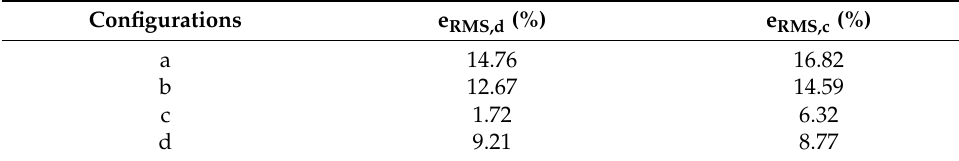
Table 1. Root-mean squares of the displacements and